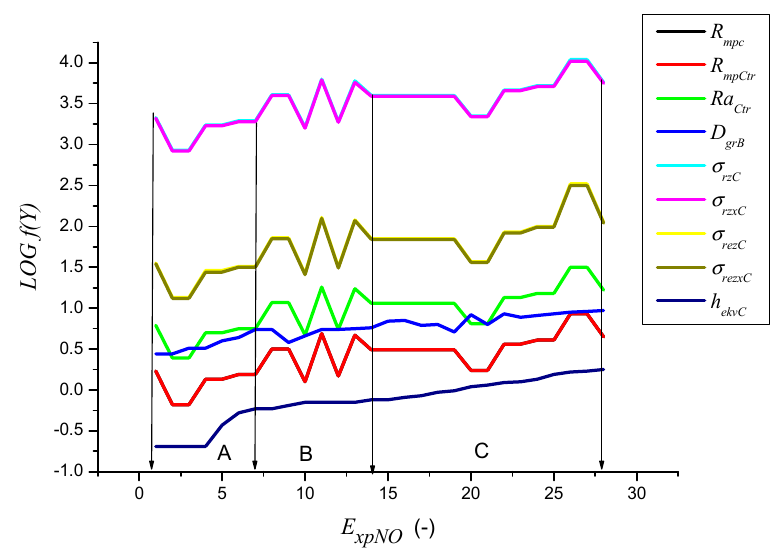
Figure 10. Comparison of working parameters LOG f ( W p ) = f ( E xpNO ) for Stellite 6, where: Section A ( E xpNO 1-6) insufficient roughness for the desired adhesion, Section B ( E xpNO 6-21) very good roughness for the desired adhesion, Section C ( E xpNO 21-24) sufficient roughness for the desired adhesion.